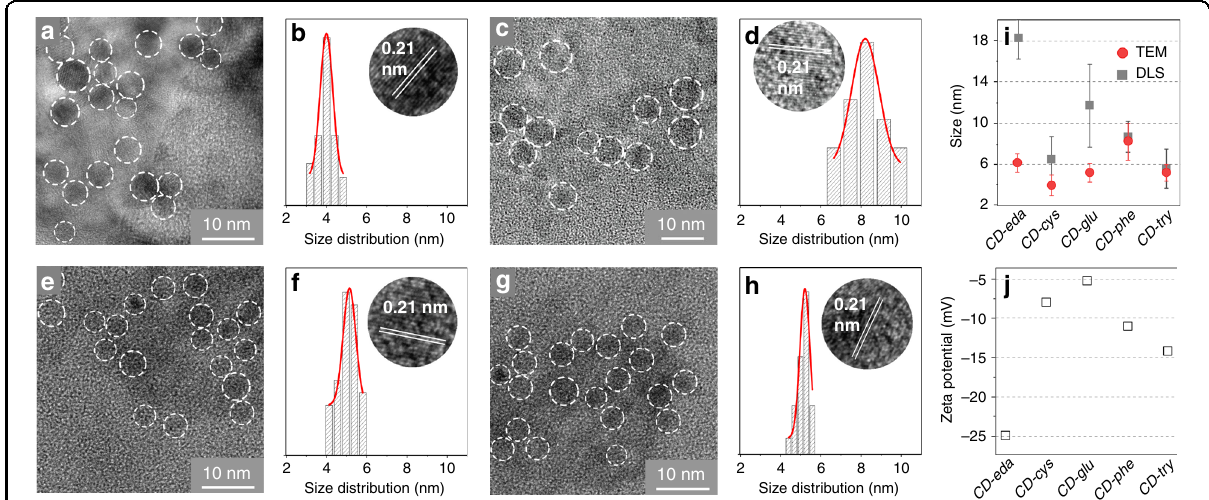
Fig. 2 Morphologies of CD samples. CD-cys ( a , b ), CD-glu ( c , d ), CD-phe ( e , f ), CD-try ( g , h ). a , c , e , g TEM images; b , d , f , h size distribution histograms and HRTEM images (insets). i Comparison of CD sizes estimated from TEM images (red circles) and DLS measurements (gray squares). j Zeta potentials of CD